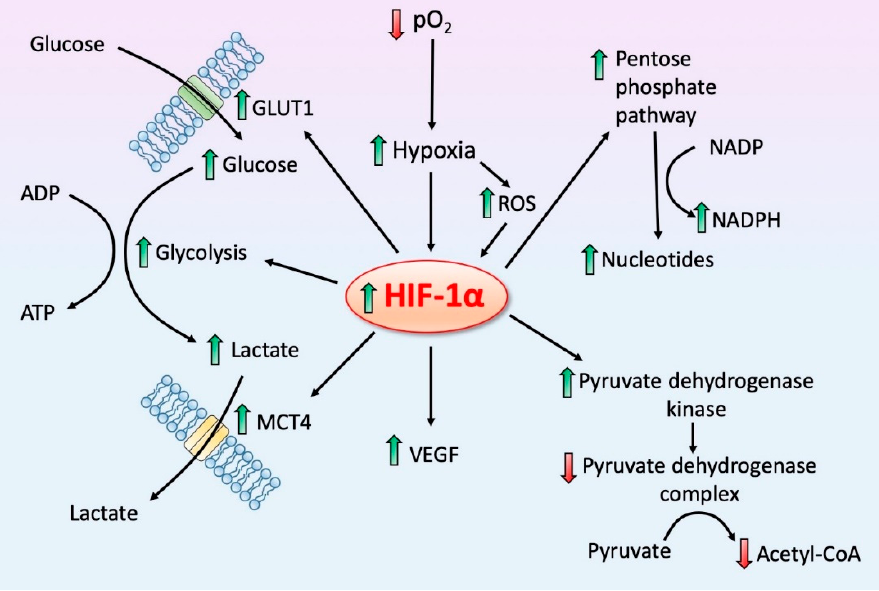
Figure 5. Hypoxia inducible factor-1 alpha (HIF-1 α ) is a central transcription agent in mediating Warburg-type metabolism within diseased cells. HIF-1 α is part of an oxygen sensing system which becomes activated when the partial pressure (pO2) of intracellular oxygen becomes depressed, that is, when cells become hypoxic. A primary means by which HIF-1 α promotes Warburg-type metabolism is by upregulating the mitochondrial enzyme pyruvate dehydrogenase kinase which, in turn, inhibits pyruvate dehydrogenase complex thereby reducing the conversion of pyruvate to acetyl coenzyme A in the mitochondria. The reduction of acetyl coenzyme A in the mitochondrial severely restricts the intramitochondrial synthesis of melatonin (see Figure 2). Further, HIF-1 α promotes the pentose phosphate pathway (see Figure 4) and upregulates glycolysis by stimulating the glucose transporter (GLUT1), which accelerates the influx of glucose (the “sweet tooth” phenomenon), and promoting the efflux of lactate by stimulating the monocarboxylate transporter 4 (MCT4) which also stimulates neovasculogenesis by upregulating vascular endothelial growth factor (VEGF). Mela- tonin, by directly or indirectly inhibiting HIF-1 α , reverses the Warburg effect and prevents the associated metabolic activities. Reactive oxygen species, which are produced more abundantly under hypoxic conditions, aid in the stabilization of HIF-1 α One critical function of HIF-1 α is the stimulation of the mitochondrial PDK. PDK is the enzyme that serves as the gatekeeper for the entrance of pyruvate, the end product of glycolysis, into the mitochondria [112,113]. The activation of PDK, by HIF-1 α , or any other means, leads to the phosphorylation of the E1 α subunit of pyruvate dehydrogenase com- plex (PDC), which inactivates it [114,115]. When this link is broken due to the inhibition of PDC, pyruvate is re-routed to the cytosol where it undergoes fermentation to lactate. The processes, collectively identified as the Warburg effect (Figure 3), are commonly as- sociated with solid tumors and contribute significantly to their hardiness, invasiveness